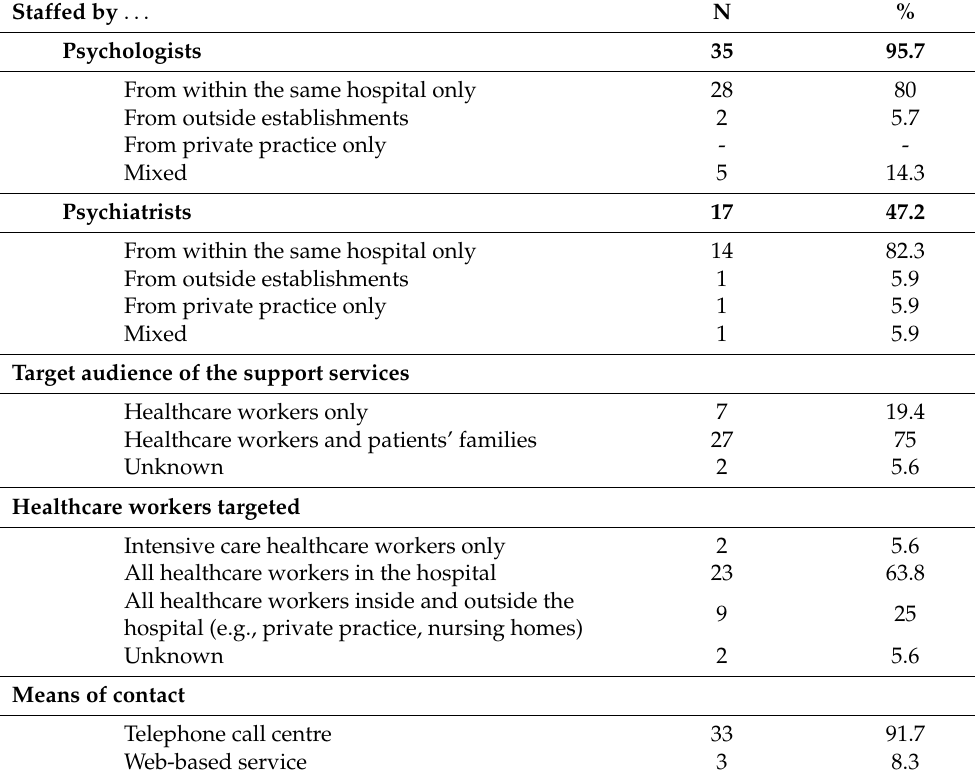
Table 1. Characteristics of the 36 mental health support services identified among 77 centres partici- pating in the PsyCOVID-ICU